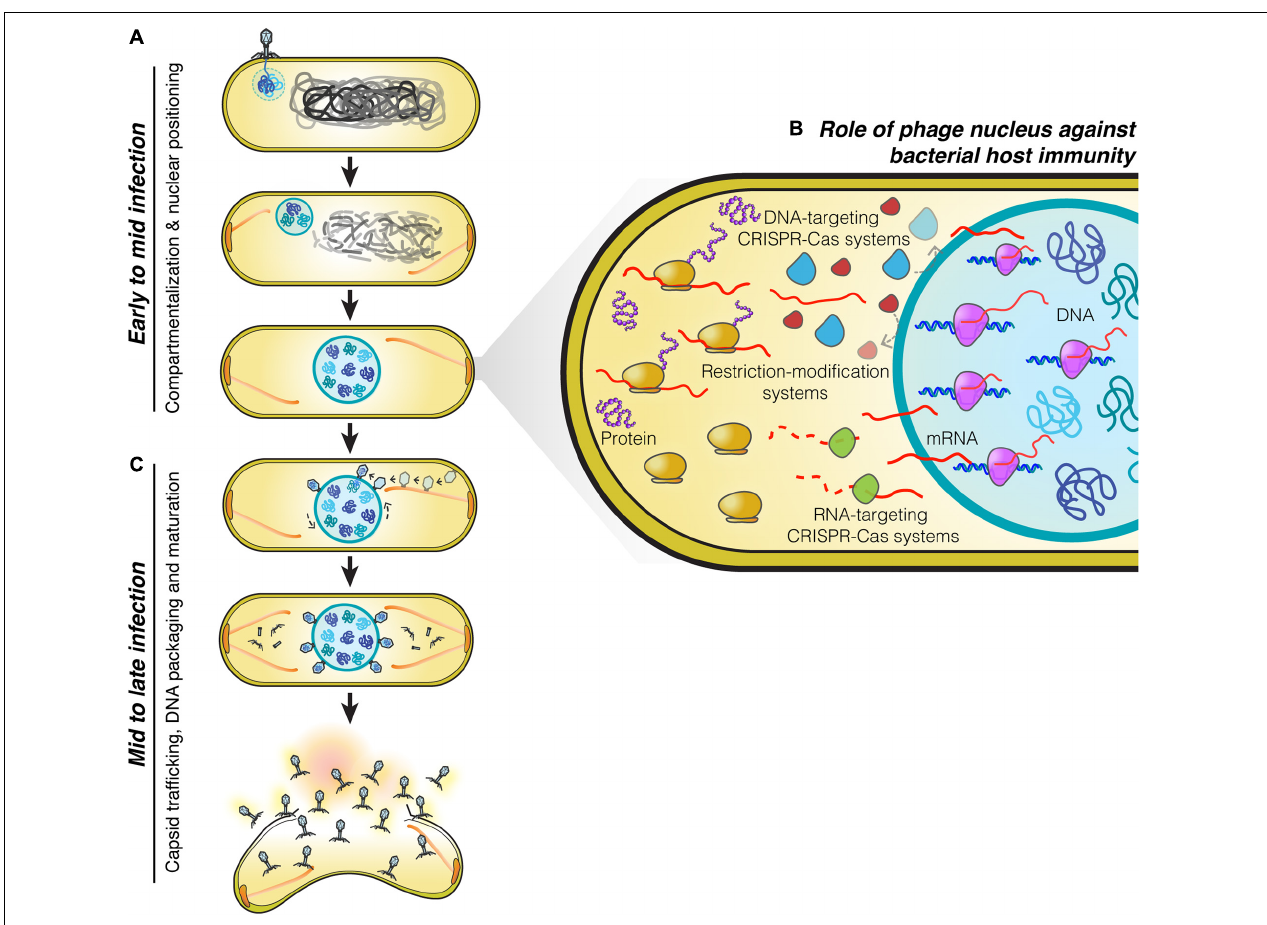
FIGURE 1 | Replication machinery of nucleus-forming jumbo phages. (A) At the beginning of infection, phages attach to the bacterial cell membrane close to the pole and inject their genome into the cell. A nucleus-like structure is then formed by the shell protein assembling around and enclosing the phage genome. PhuZ filaments that emanate from the cell pole push the phage nucleus containing the replicating phage genome toward midcell while the host genome is degraded. When the nucleus arrives at midcell, it is met by an opposing PhuZ filament, resulting in its oscillation close to midcell. (B) The phage nucleus is formed by a proteinaceous shell which provides the phage genome with protection from bacterial host defense systems that target DNA because they are excluded from the shell. Phage mRNA is transported to the cell cytoplasm to initiate protein translation. Host mRNA-targeting CRISPR-Cas systems are therefore able to destroy phage mRNAs, and as a result, these phages remain sensitive to mRNA-targeting defense mechanisms (Erb et al., 2014; Chaikeeratisak et al., 2017b, 2019; Mendoza et al., 2020). (C) Midway through infection, procapsids assemble throughout the host cell close to the cell membrane and traffic along treadmilling PhuZ filaments toward the phage nucleus where they dock on its surface to initiate DNA packaging. Mature capsids detach from the phage nucleus and assemble with tails in the cell cytoplasm. Cell lysis occurs at the end of infection and mature phage particles are released from the